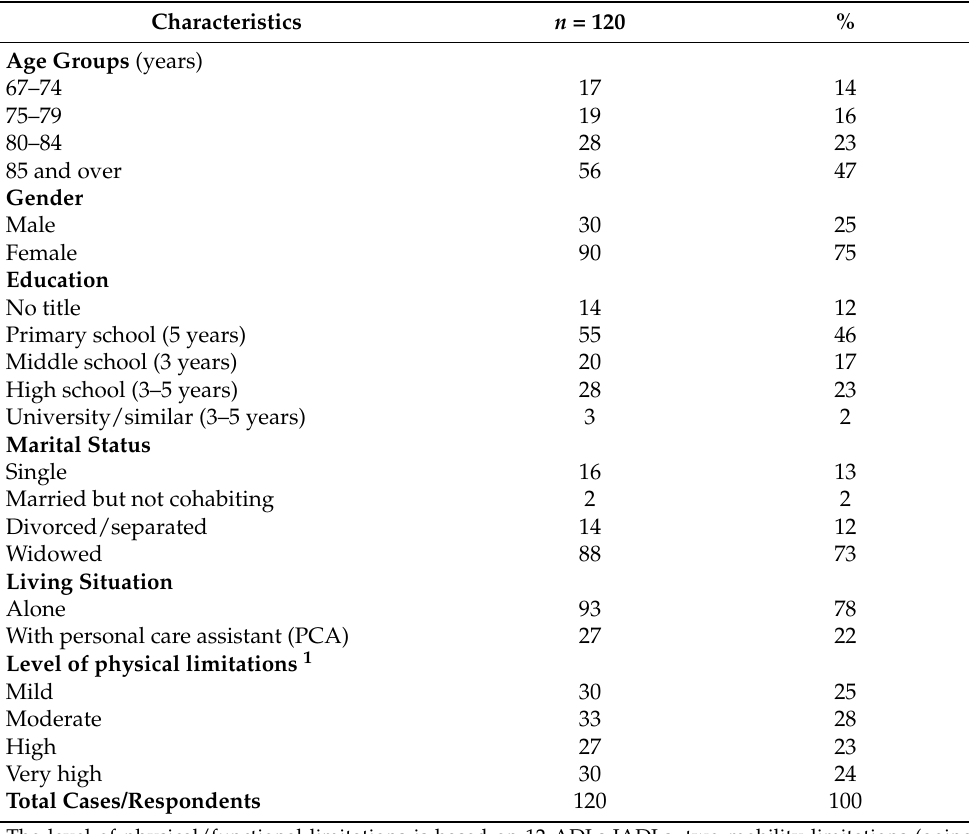
Table 2. Sample Characteristics (absolute values/ n and